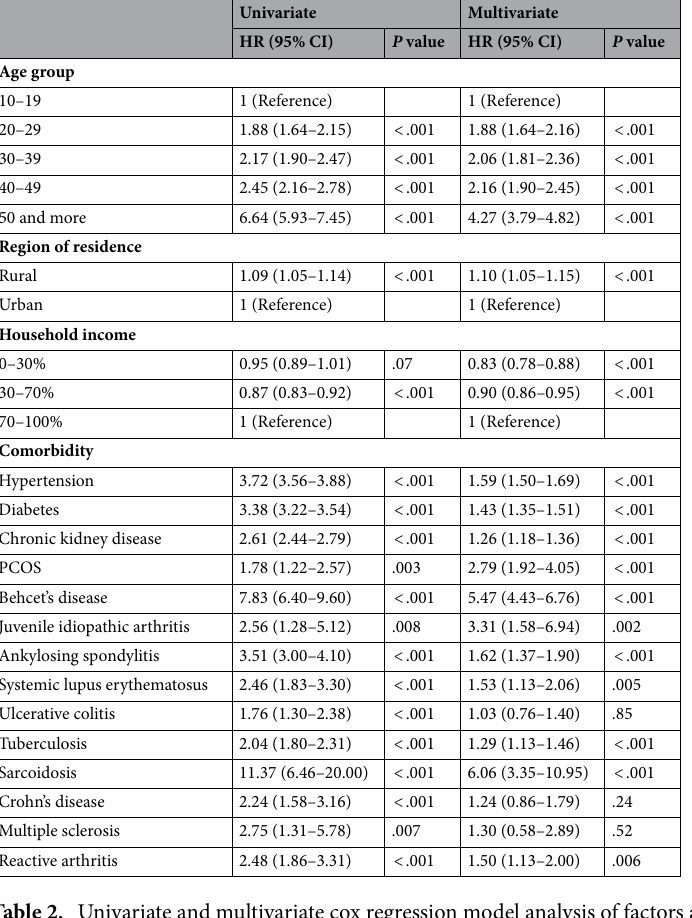
Table 2. Univariate and multivariate cox regression model analysis of factors associated with non-infectious uveitis. Ref Reference, PCOS Polycystic ovary syndrome, HR Hazard ratio.